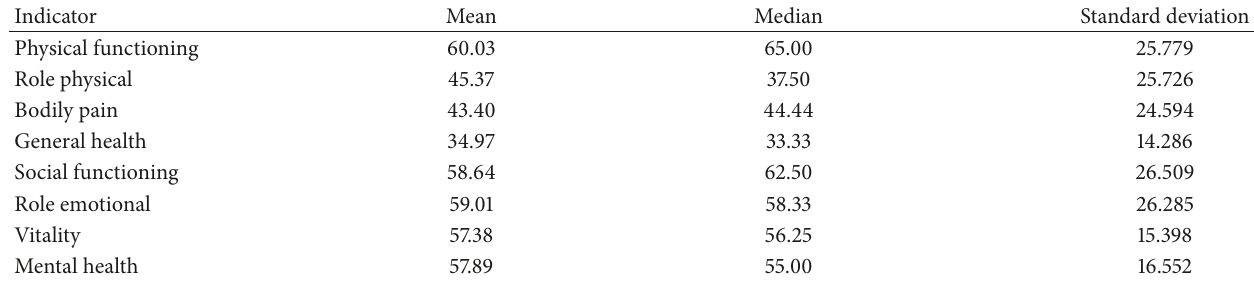
Table 2: Mean scores for different domains of health related quality of life